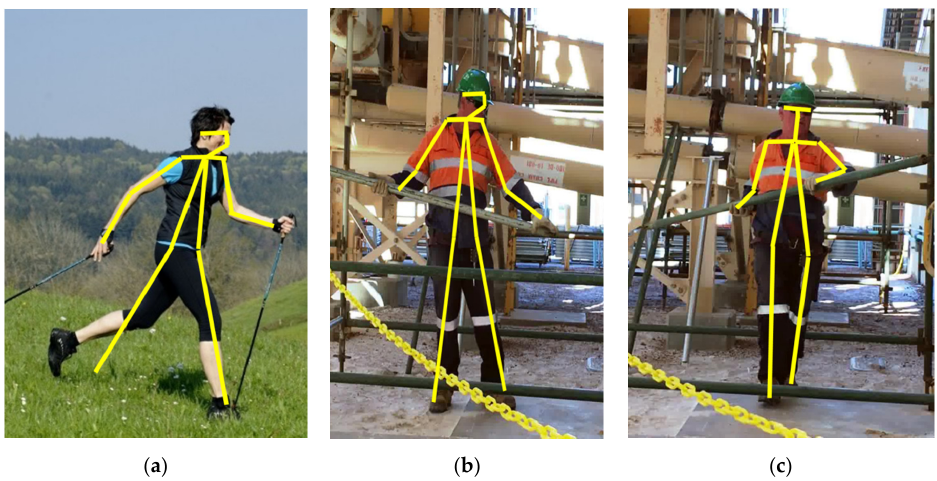
Figure 3. Inter-class similarity and intra-class variation: ( a , b ) represent walking and transporting, two different activities, while their skeleton appearance shows similarity from the same viewpoint; ( b , c ) display the same activity, while their skeleton appearances presents a variation from different viewpoints.